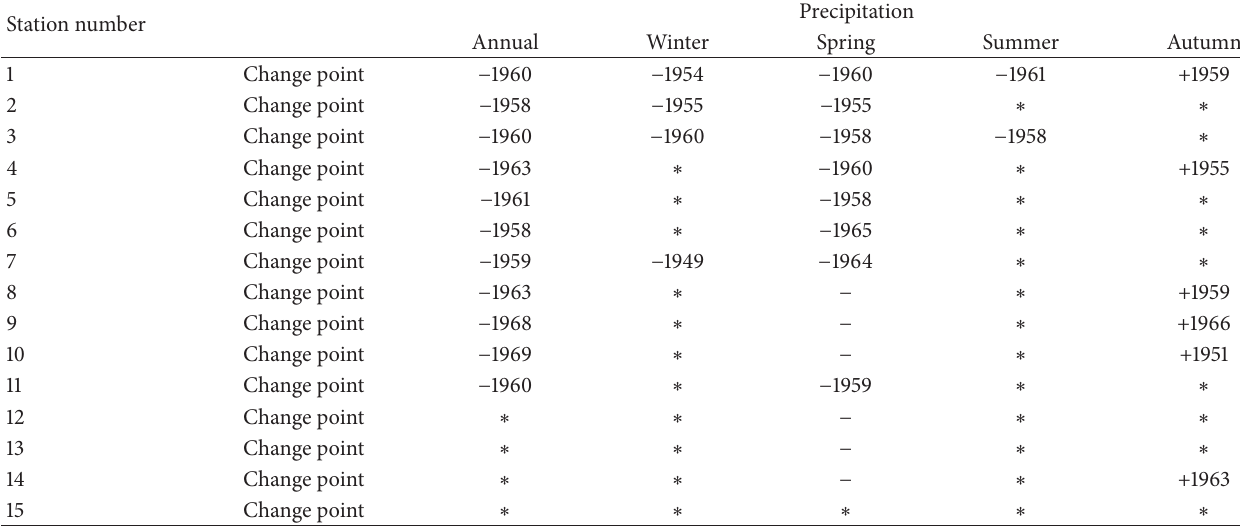
Table 2: Change point detection during the period of 1901–2013.